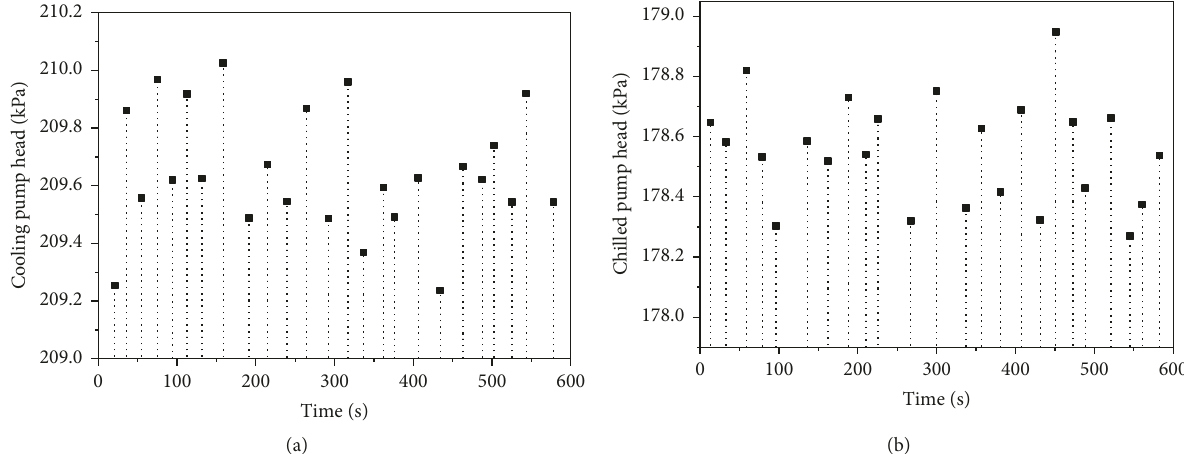
Figure 11: Stability test of water system head. (a) Stability test of cooling water head. (b) Stability test of chilled water head.